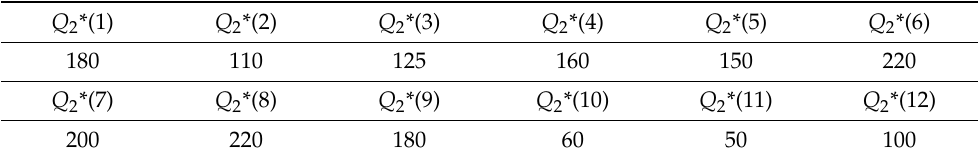
Table 10. Optimal delivery plan for warehouse 2 ( τ * = 1).